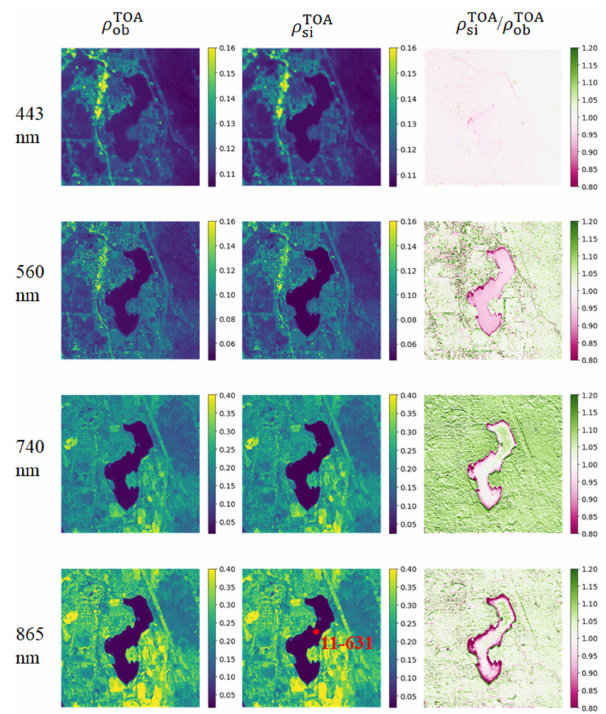
Figure 14. Comparison of the four S2/MSI bands (443 nm, 560 nm, 740 nm, and 865 nm) ob- served ( ρ TOA ) and the 3-D RTM simulated TOA reflectance ( ρ TOA ob also